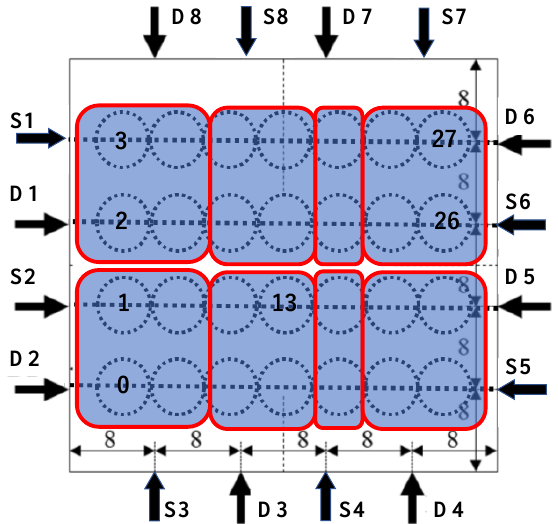
Figure 1. The configuration of target tissue. The dimensions are 4 cm × 4 cm. The tissue is divided into 28 domains, each of which can possess a round absorber with a diameter of 5 mm. Eight incident beam directions (labelled S1–S8) and eight detector positions (D1–D8) are shown. We divide the whole area into eight groups, each of which has four or two